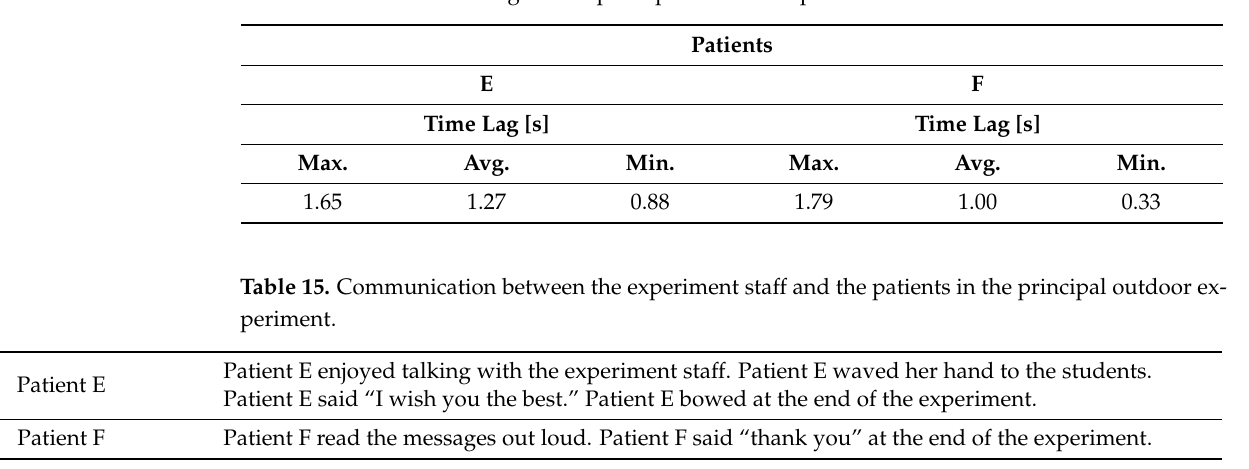
Table 14. Results of time lags in the principal outdoor experiment.